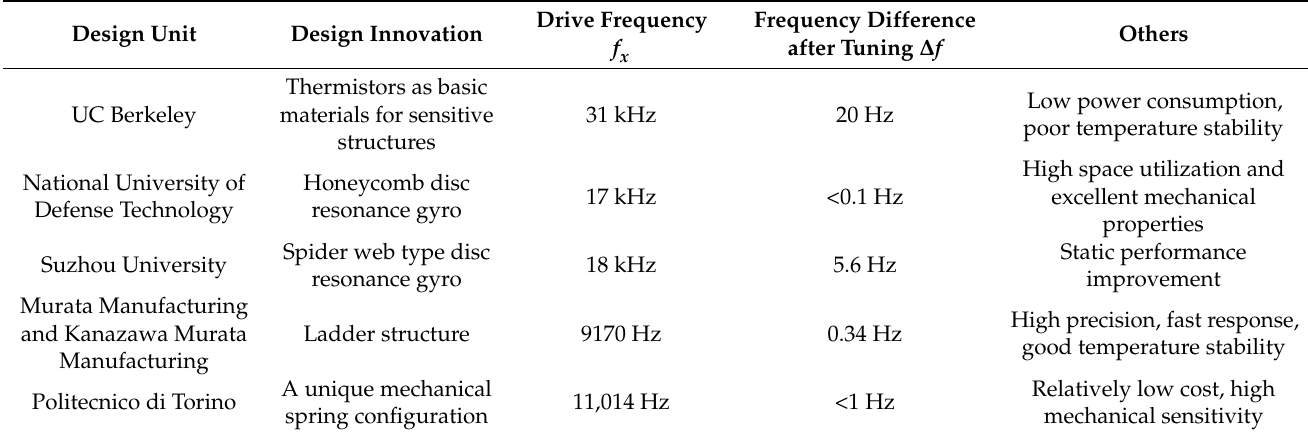
Table 2. Comparison of mode-matching schemes for the structural mass increase and decrease